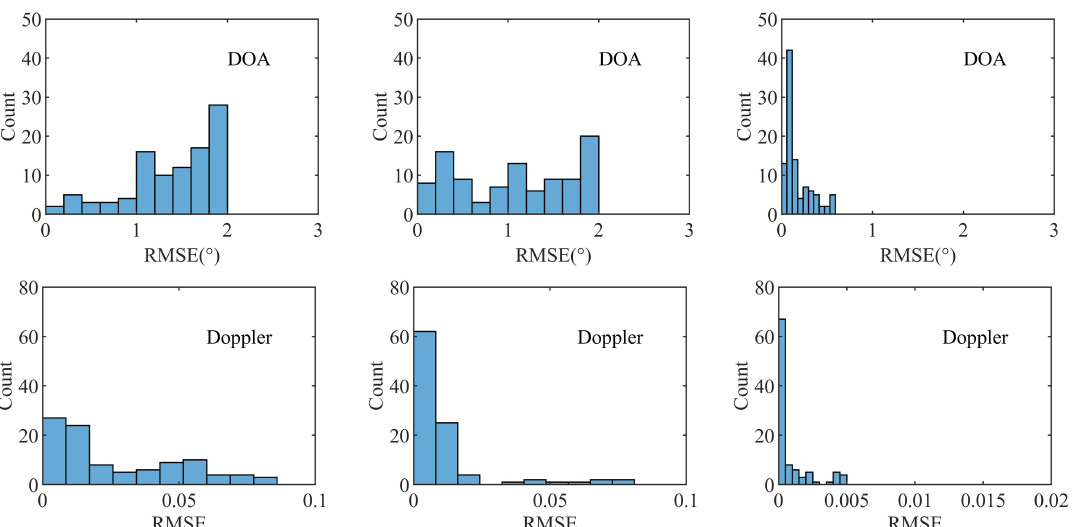
Figure 4. RMSE histograms of three cases (the top subplots are RMSE histograms of DOA, while the bottom subplots are RMSE histograms of